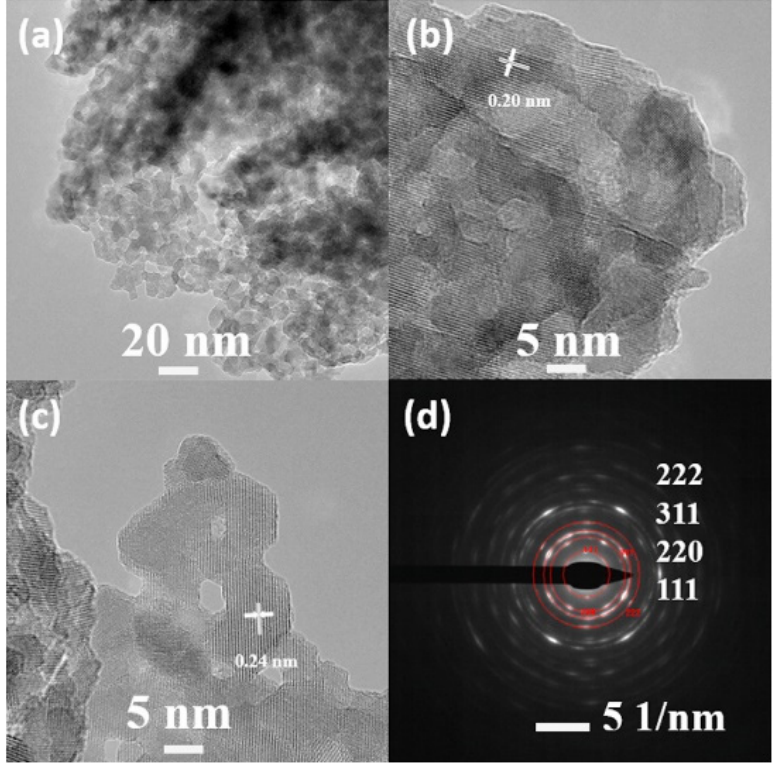
Figure 2. ( a – d ) TEM and HR-TEM images of a MnCo 2 O 4 microsphere. Reproduced with permission from Mobinul Islam, A high voltage Li-ion full-cell battery with MnCo 2 O 4 /LiCoPO 4 electrodes; published by Elsevier, 2020 [12].